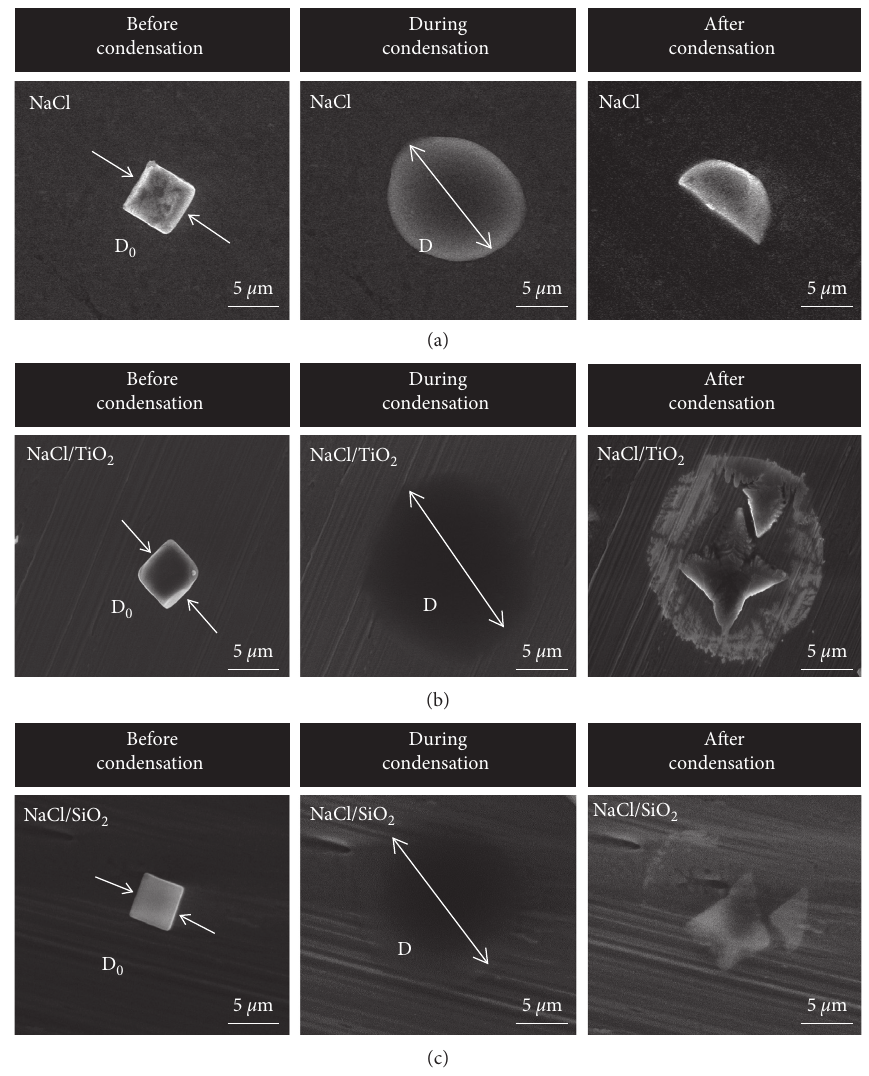
Figure 15: In situ condensation experiments inside ESEM at three key stages before condensation (left: dry samples); during con- densation (center: samples at equilibrium), and after condensation (right: dried sample after water is removed) performed, respectively, on (a) NaCl (b) NaCl-TiO 2 , and (c) NaCl-SiO 2